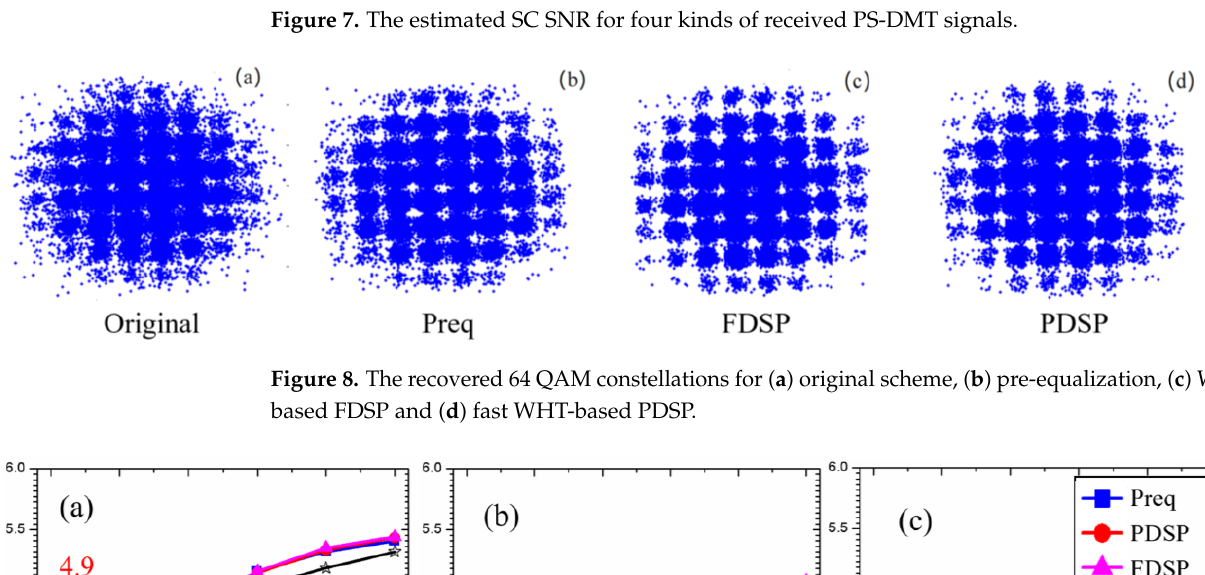
Figure 10. Measured BER performance for four kinds of PS-DMT signals versus ROP. 5. Conclusions In this paper, we proposed and experimentally investigated a low-complexity fast WHT-based PDSP scheme to combat the unbalanced impairments and reduce the im- plementation complexity of PS-enabled DMT IMDD transmission systems. After 50 km SMF transmission, the results show that pre-equalization, WHT-based FDSP and fast WHT-based PDSP schemes have almost the same BER and GMI performance. Com-